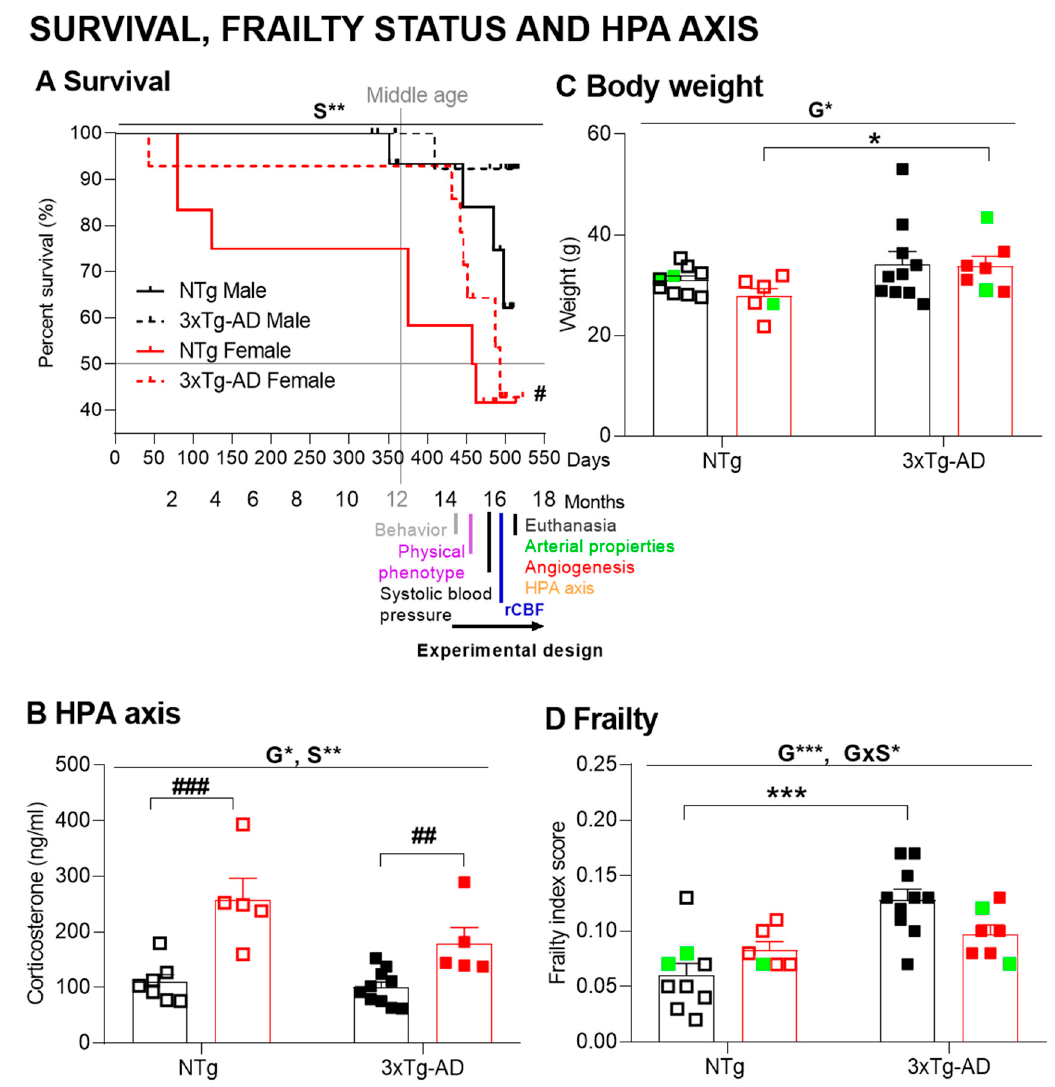
Figure 1. Survival, hypothalamic–pituitary–adrenal (HPA) axis endocrine status and physical health. ( A ) Survival; ( B ) corticosterone levels; physical health: ( C ) body weight, and ( D ) frailty scores of 14-month-old mice. Results are expressed as the mean ± SEM. Initial sample size: NTg, male n = 10, female n = 7; 3xTg-AD, male n = 10, female n = 9. Bars illustrate the genotype groups, as indicated in the abscissae. Symbols are used to illustrate individual values of males (black, left panel) and females (red, right panel). In green: the no-survivors. Statistics: 2 × 2 factorial ANOVA analysis design: genotype (G), sex (S) and genotype × sex (G×S) interaction effects, * p < 0.05, ** p < 0.01, *** p < 0.001 (above line). Student t -test comparisons: * p < 0.05, ** p < 0.01, *** p < 0.001 vs. the corresponding NTg group; # p < 0.05, ## p < 0.01, ### p < 0.001 vs. the corresponding male group.